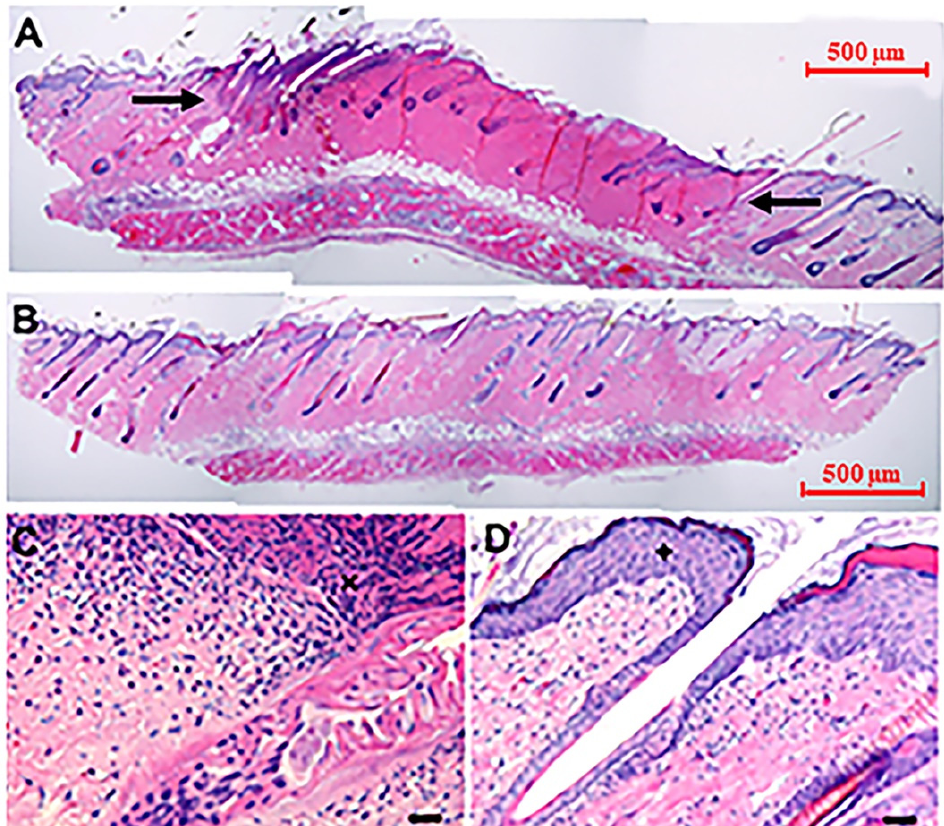
Figure 7. Histological analysis after cutaneous moderate heat-assisted GET 48 h after GET. Images are representative of 3–4 individual subjects. ( A ) injection of pDNA followed by 72 pulses at 45 V (45 V 72p no heat) between black arrows indicate areas of damage and ( B ) 36 pulses at 45 V after the application of moderate heat from an infrared laser (45 V 36p + heat). 40 × . ( C ) Cell infiltrate visible at site of damage following 45 V 72 pulses, 200 × , scale bar = 10 µ m. ( D ) Intact tissue with no apparent damage after 45 V 36p + heat, 200 × , scale bar = 10 µ m. Table 3. Factor IX expression following GET with or without